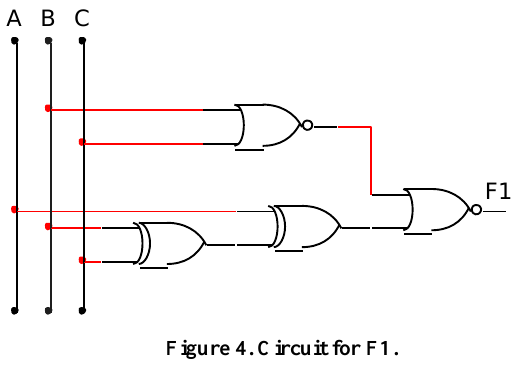
Figure 4. Circuit for